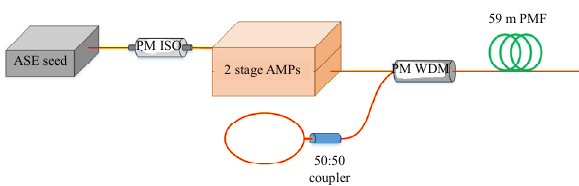
Fig. 1 Experimental setup of the Raman laser (ASE: amplified spontaneous emission, PM: polarization maintaining, ISO: isolator, AMP: amplifier, WDM: wavelength division multiplexer, PMF: polarization maintaining